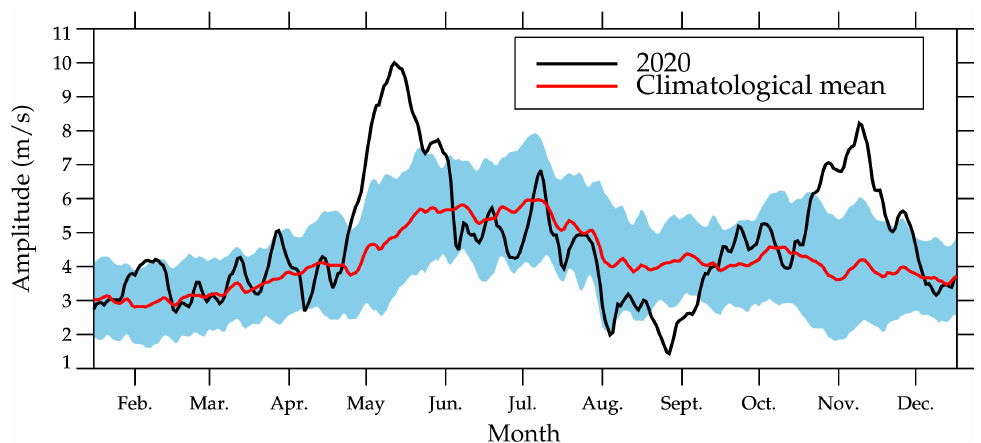
Figure 9. The climatological mean amplitudes (red line) of E5 10DW at 32 ◦ S and ∼ 11 km. The black line is amplitudes of E5 10DW at 32 ◦ S and ∼ 11 km in 2020. The sky blue region represents the standard